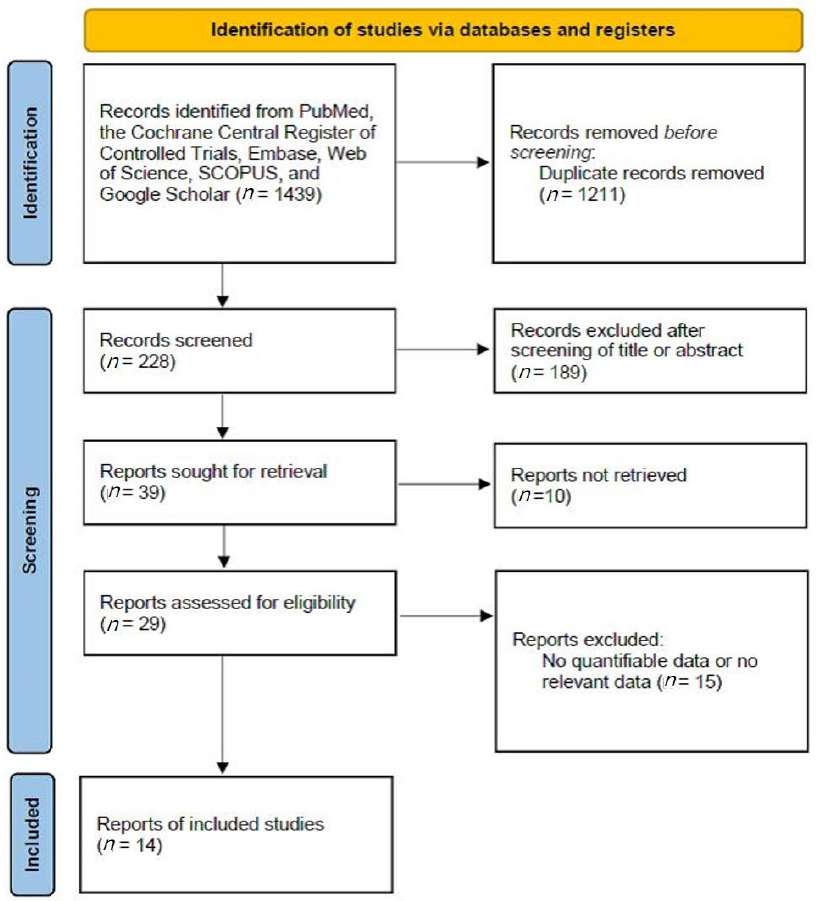
Figure 1. Summary of the search strategy.